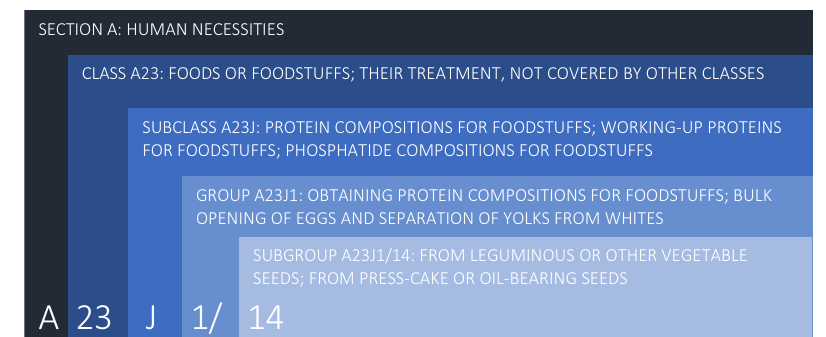
Fig. 1 De fi nition of subgroup A23J1/14 based on the International Patent Classi fi cation (IPC). Darker blue categories represent broader fi elds, whereas lighter blue categories concern more speci fi c fi elds. Data source: World Intellectual Property Organization (WIPO). Elaborated by the